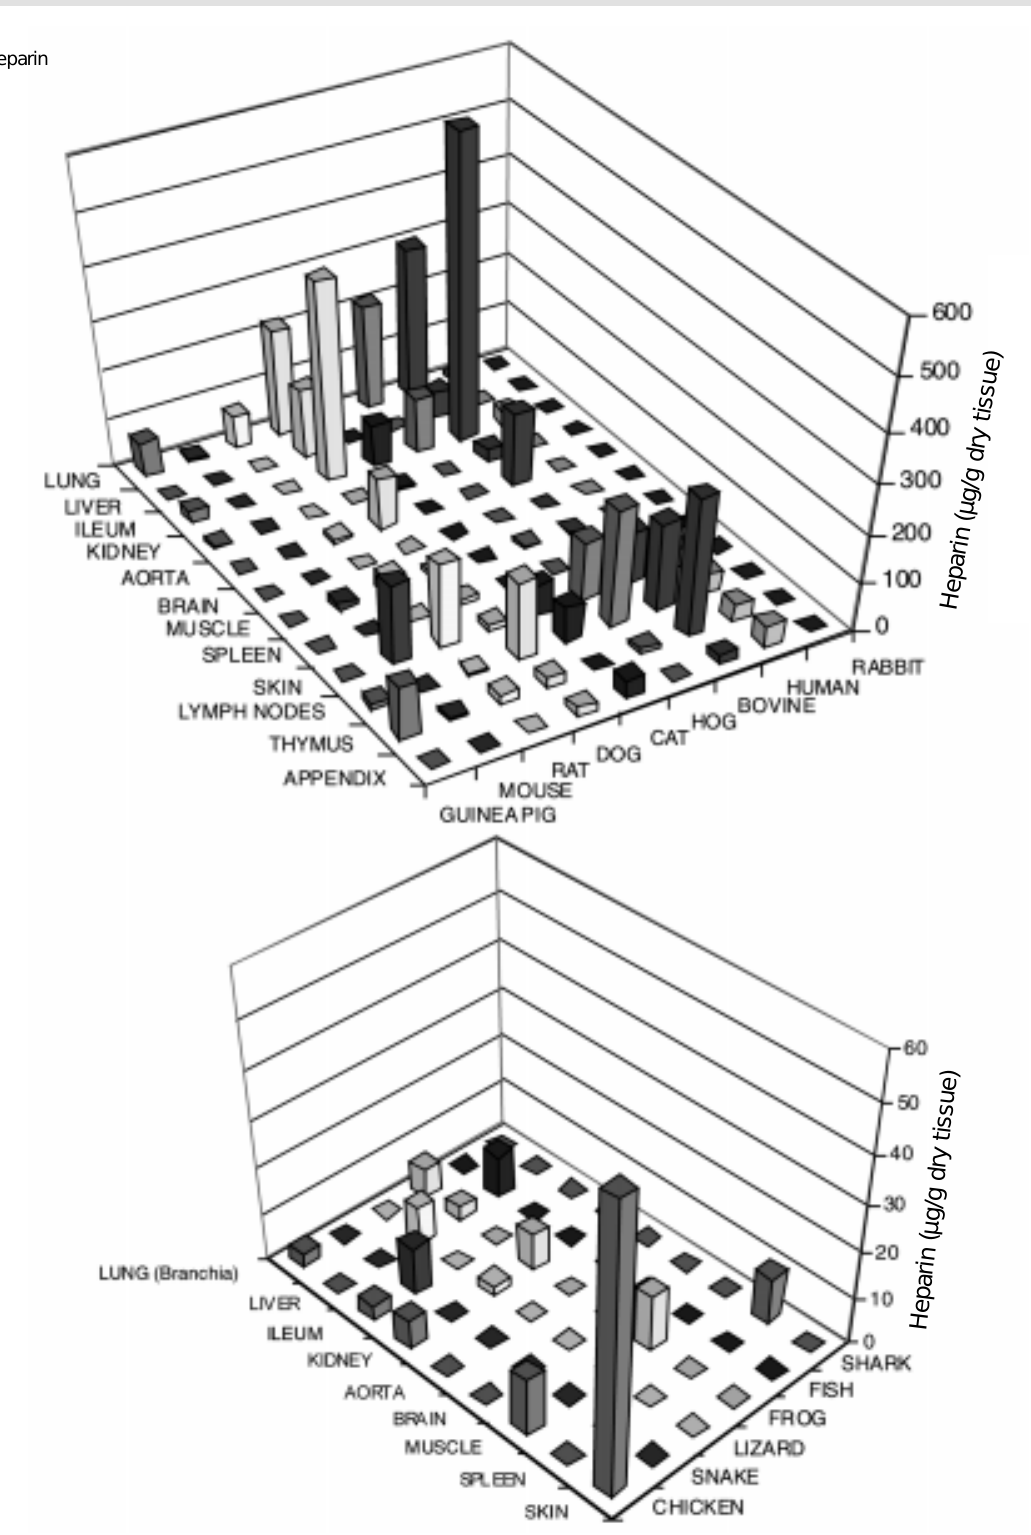
Figure 7 - Distribution of heparin in vertebrate